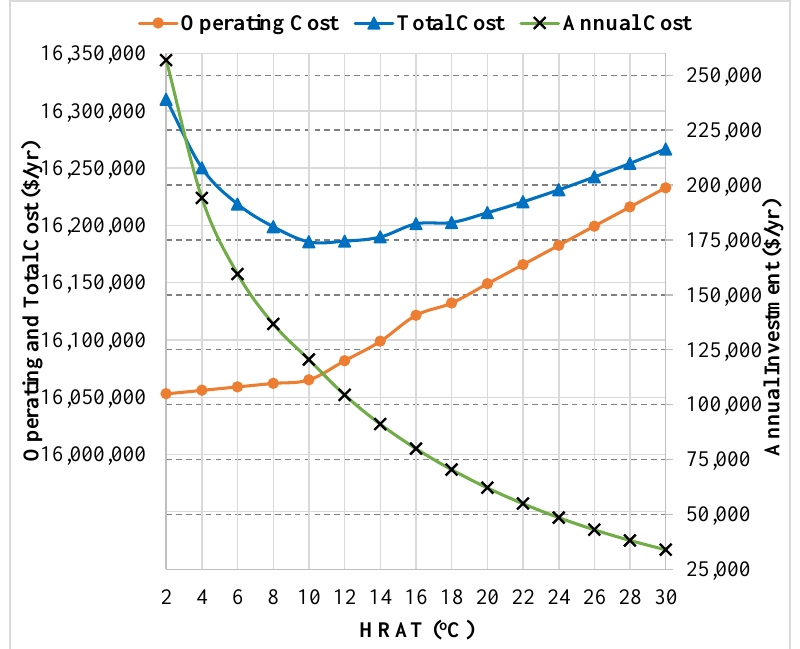
Figure 7. Economic profile of the optimized HEN using option (5).